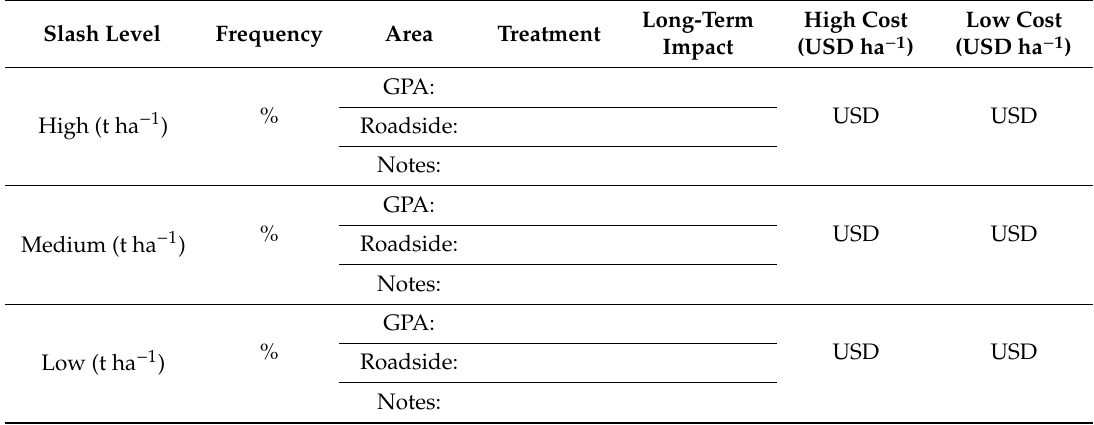
Table 2. Framework for determining site preparation costs compared with slash level accounting